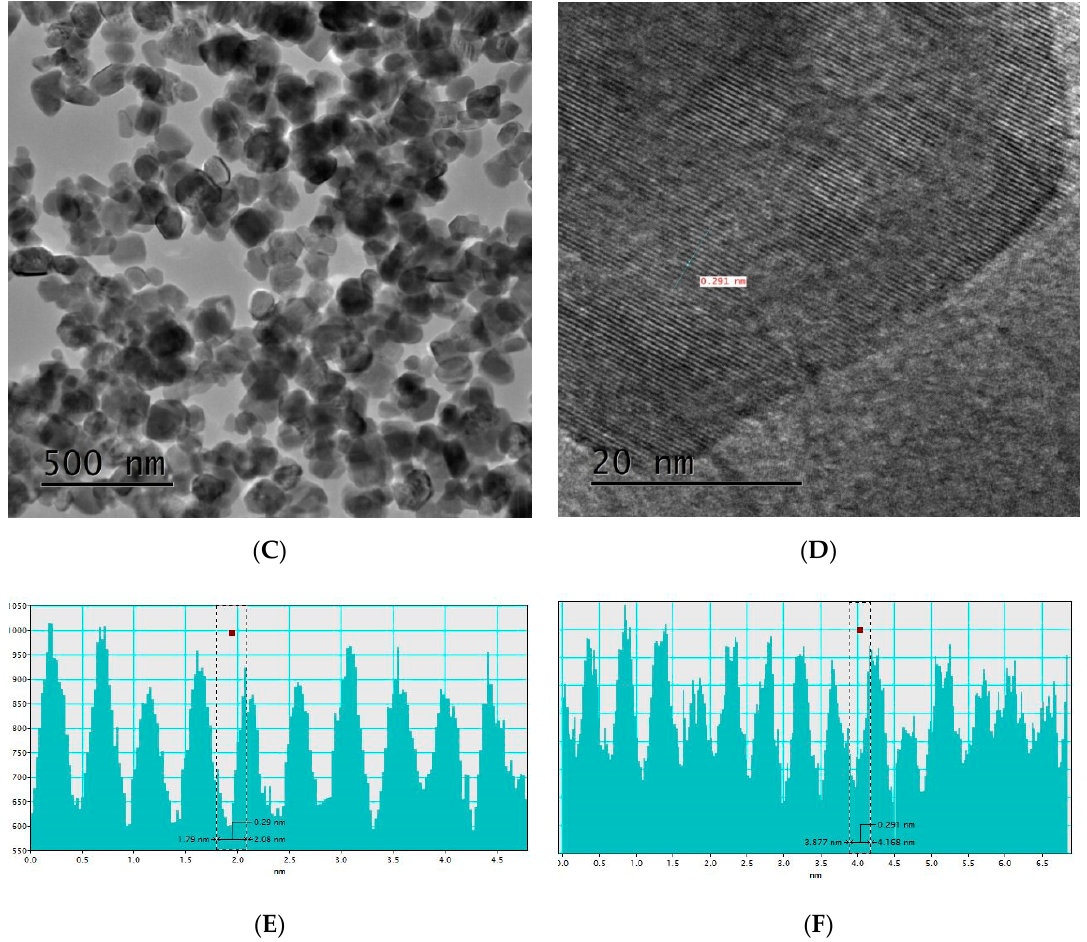
Figure 3. TEM images of pure ( A , B ) and Al doped ZnO ( C , D ) at a concentration of 3 mol %. The corresponding HRTEM d -spacing measurements are shown in ( E ) and ( F ).